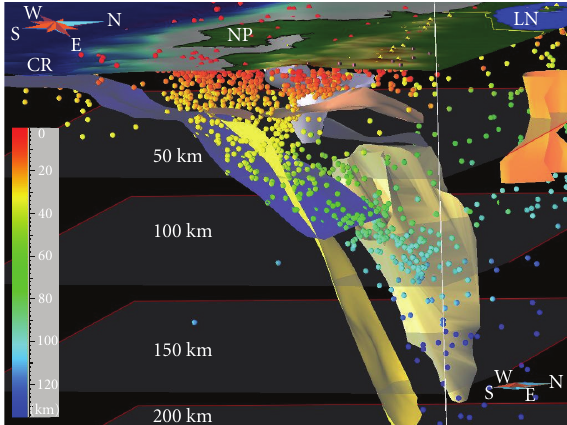
Figure 12: Looking roughly from southeast along the subduction zone with the slab below Costa Rica, the earthquake hypocenters from local networks of SFB 574 subproject A2 for a 6-month period are shown as balls. Not only are they distributed on the modeled slab but also they form an approximately. 45 ◦ channel in direction to the volcanic chain. The red-bordered gray surfaces are 50 km separated from each other for orientation in